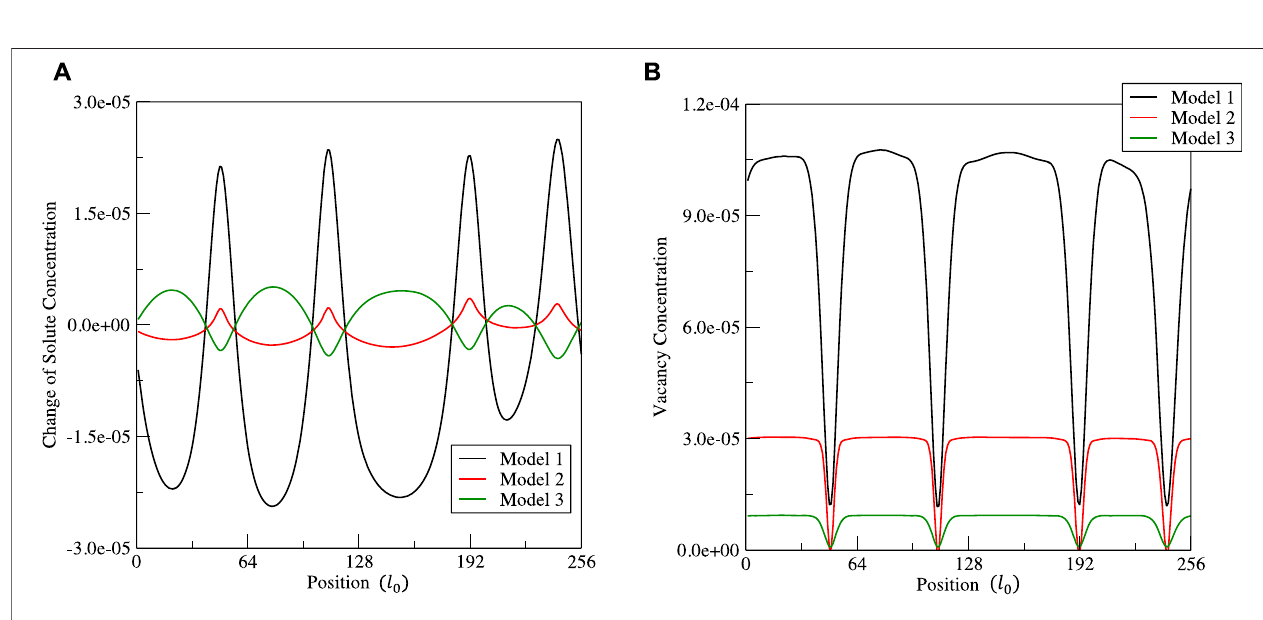
− d Ai (cid:23) . (A) the solute d BV d Bi